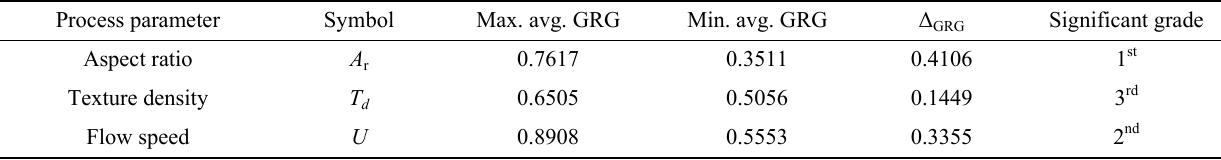
Table 7 The most significant process parameter of triangle T1 bottom profile. Process